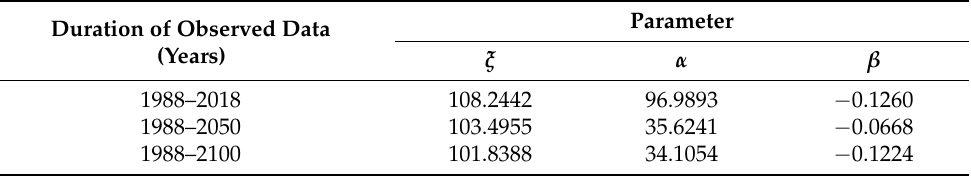
Table 6. Parameters calculated by GEV distribution using L-moment method considering RCP 4.5 scenario at Gimhae rainfall station.